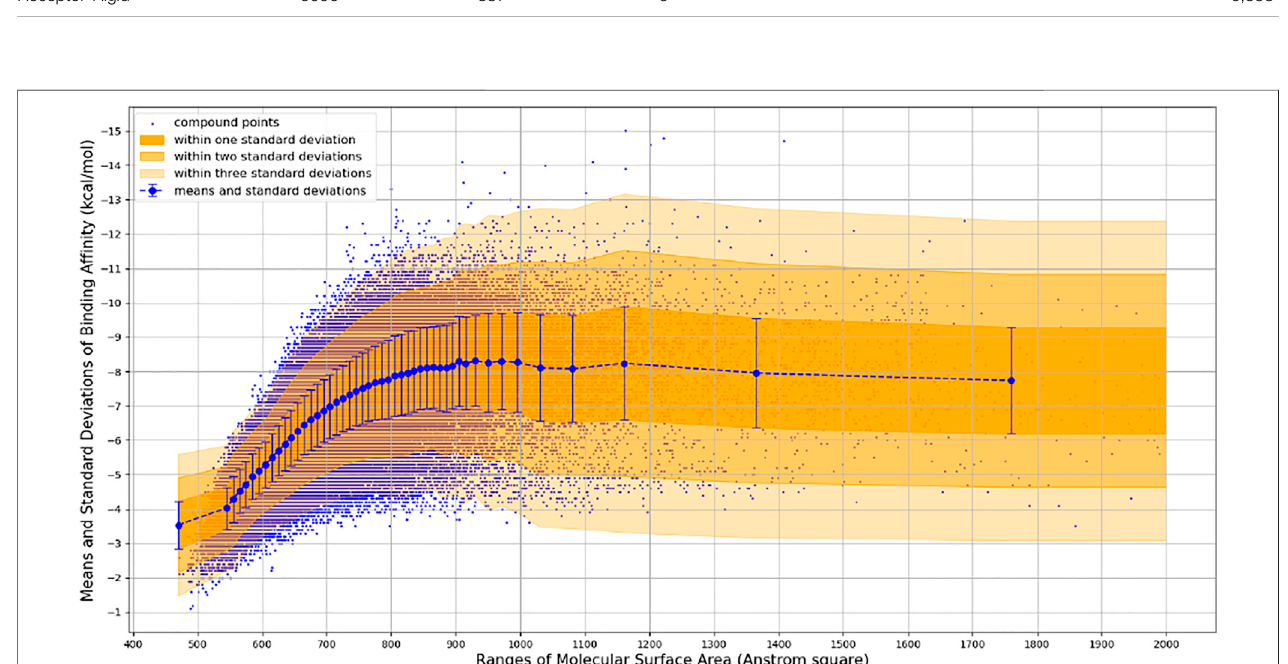
FIGURE 3 | Binding Energy vs . Molecular Surface Area of Receptor-Flexible Docking Results. The surface areas are binned with 10 Å 2 , and then the mean and standarddeviationofbindingenergywithineachsurfaceareabiniscalculated.Inordertogetmorereliablestatisticalresults,weuseasimpleadaptivestrategytomerge surface area bins so that each surface area bin contains at least 1,000 compound data